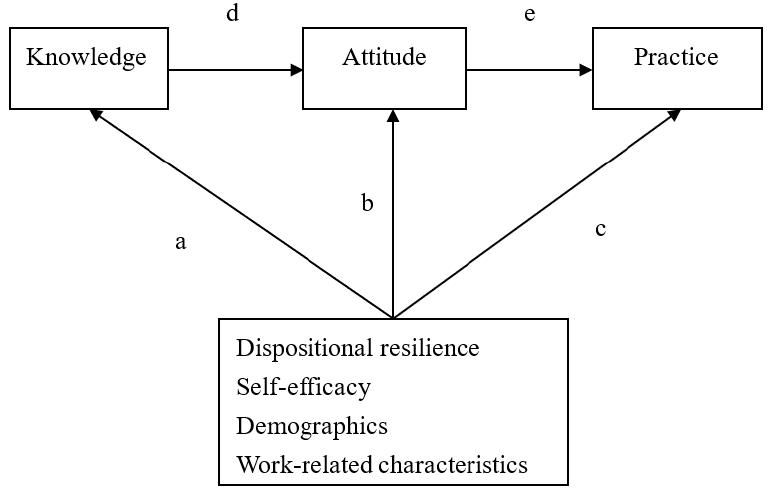
Figure 1. Path modeling. ( a . the standard coefficients of covariates to knowledge; b . the standard coefficients of covariates to attitude; c . the standard coefficients of covariates to practice; d . the standard coefficient of knowledge to attitude; e . the standard coefficient of attitude to practice)